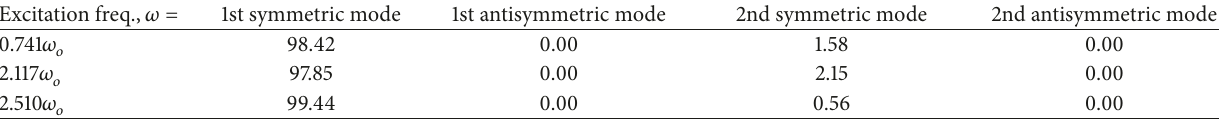
(a) Mode convergence for various excitation frequencies (nonchaotic, ℎ = 2 mm, 𝐿 𝑥 = 0.5 m, 𝐿 𝑥 = 0.6 m, 𝐵 = 0.4 m, 𝜉 = 0.02 , 𝑤 𝑐 = 2 mm, 𝜅 = 4 , 16 acoustic